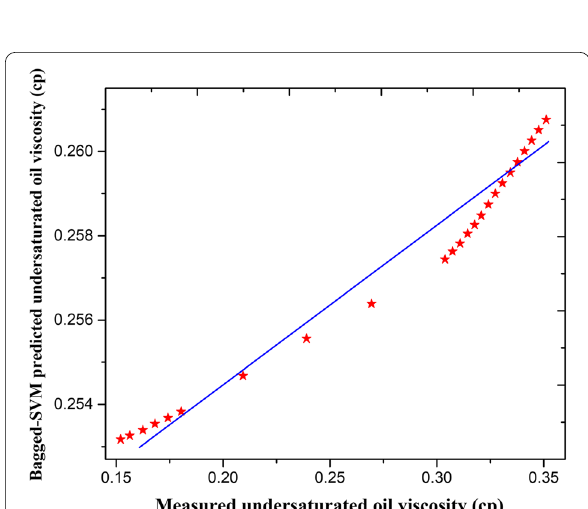
Fig. 11 Cross plot of bagged-SVM predicted values versus measured values